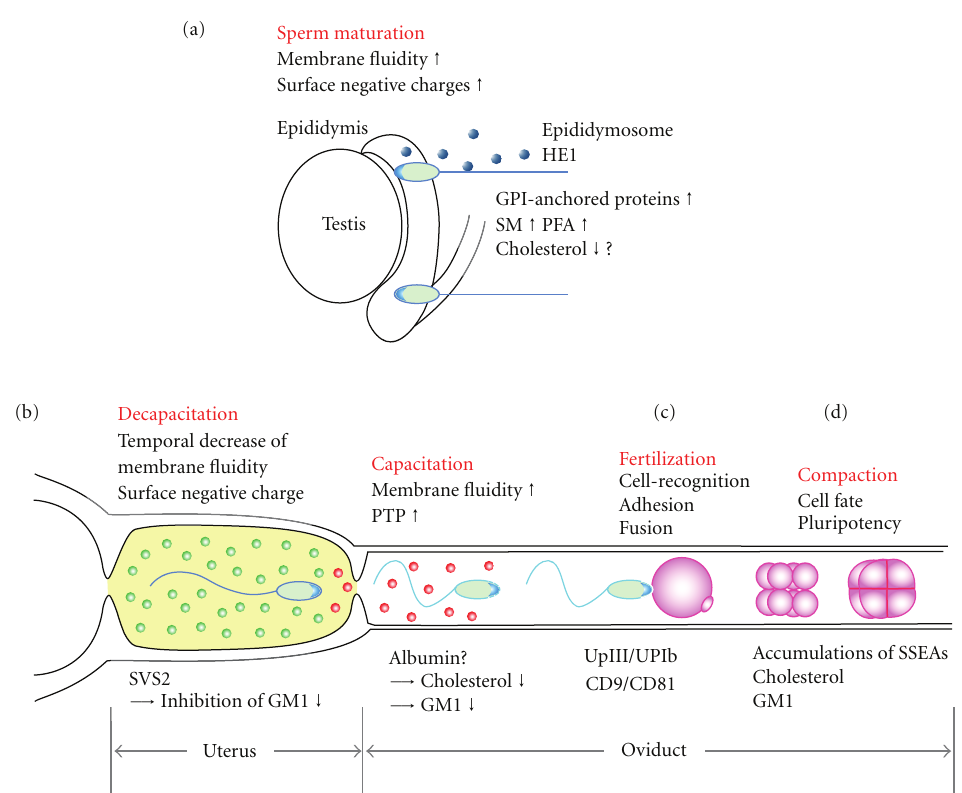
Figure 1: Schematic of lipid rafts in gamete formation, function, fertilization, and early embryogenesis. (a) Sperm mature, gaining motility and fertilizing abilities, during epididymis transit. The extracellular factors, epididymosome and HE1, dynamically change the components of the sperm plasma membrane. (GPI, glycosylphoshphatidylinositol; SM, sphingomyelin; PFA, polyunsaturated membranous fatty acids). (b) Ejaculated sperm are temporally bound to SVS2 (decapacitation). SVS2 binds to GM1 of the sperm head in the uterus, resulting in the inhibitionof the fertilizing ability ofsperm. Subsequently, the sperm that migrate to the oviduct undergo capacitation.Capacitationcausesan e ffl ux of cholesterol and G M1 from the plasma membrane and an increase of membrane fluidity and protein tyrosine phosphorylation (PTP). (c) Sperm recognize and adhere to UpIII/UpIb of Xenopus oocyte and fuse with CD9/CD81 of murine oocyte plasma membrane. These molecules are enriched in lipid rafts, and oocytes treated with cyclodextrin prevent the sperm from fertilization. (d) In early embryogenesis, SSEAs are colocalized with cholesterol and G M1 plays an important role in the compaction of an embryo, leading to the decision of cell fate and its